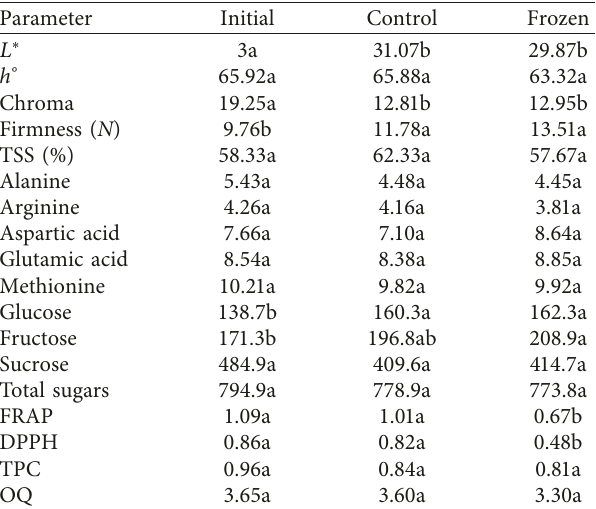
Table 3: Physicochemical parameters and overall quality of Deglet Noor date fruits on control or frozen